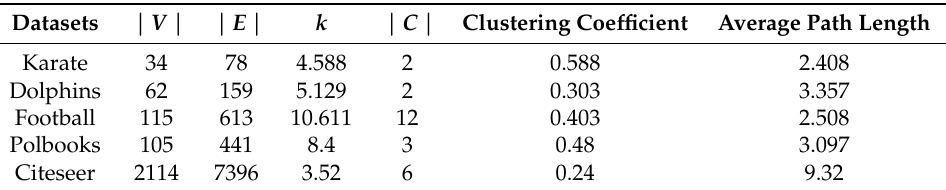
Table 4. Characteristics of real-world